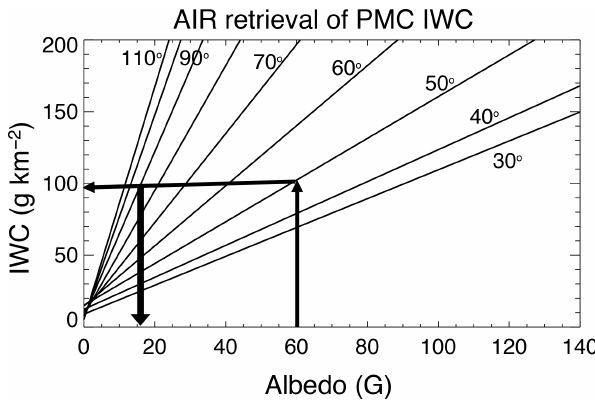
Figure 4. Illustration showing how IWC = 98gkm − 2 (horizon- tal arrow) and A( 90 ◦ ) = 16G (thick downward arrow) are derived from the AIR method from a single measurement of cloud albedo at 60G and SA = 50 ◦ (upward arrow). Each straight-line plot is cal- culated from Eq.